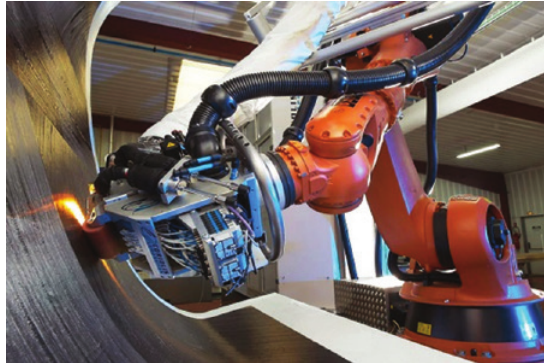
Figure 1: Six-axis anthropomorphic robot guiding an AFP processing head over a curved tool surface. Source: